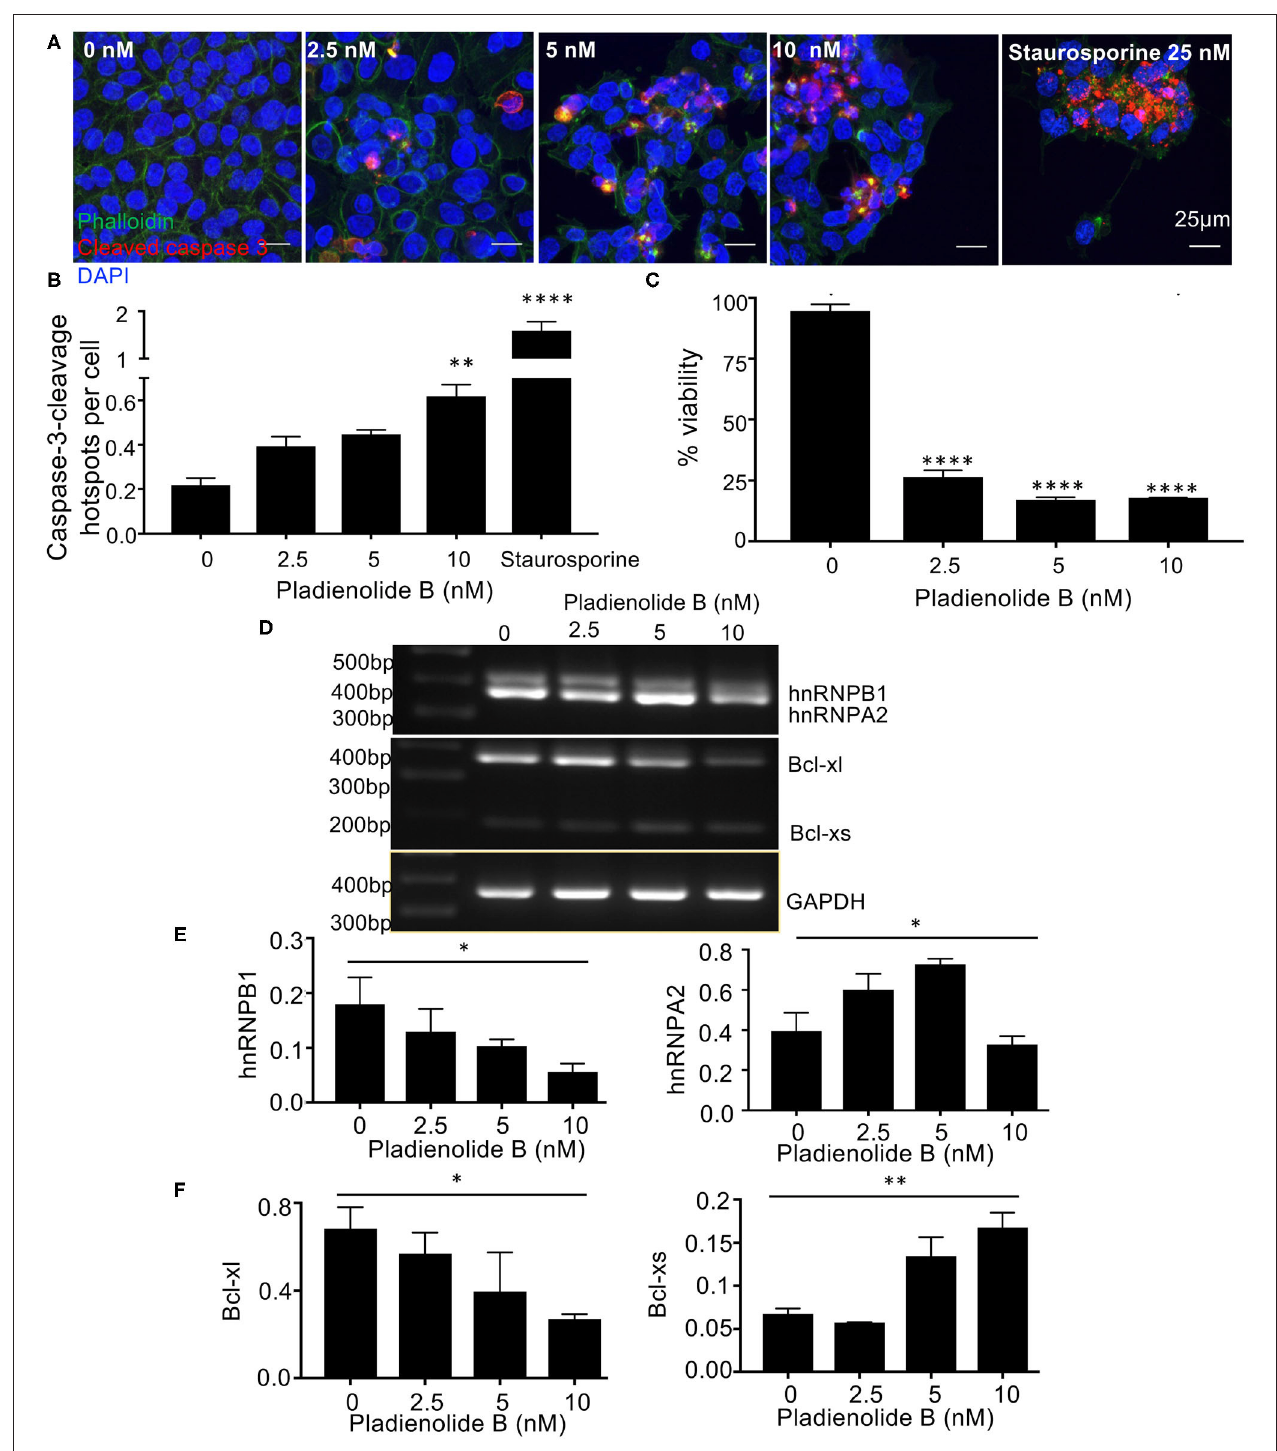
FIGURE 4 | The splicing inhibitor and antitumor compound Pladienolide B switches splicing of hnRNPA2B1 and BCL2L1 to induce apoptosis in HCT116 colon cancer cells. (A) Cells were treated with varying concentrations of Pladienolide B for 48h, fixed, permeabilized, and stained with DAPI (blue), phalloidin (green), and a Caspase-3-cleavage antibody (CCA) (red). (B) Increased caspase-3-cleavage and (C) Decreased cell viability in HCT-116 cells treated with Pladienolide B. The images were analyzed using Fiji to calculate the amount of cleaved caspase-3 in cells. mean ± SEM ( n = 3). Scale bars 25 µ m. (D) Effects of Pladienolide B on splicing of hnRNPA2/B1 and BCL2L1 in HCT116 colon cancer cells using semi quantitative PCR. (E,F) Quantitative analysis of PCR results. Quantification of splice variant expression demonstrates a decrease in hnRNB1, and an increase in Bcl-xs ( n = 3, mean ± SEM), For statistical analysis, One-way ANOVA, Dunnett’s multiple comparison test and post-hoc test for trend was used, * P < 0.1, ** P < 0.01, *** P < 0.001, **** P < 0.0001.